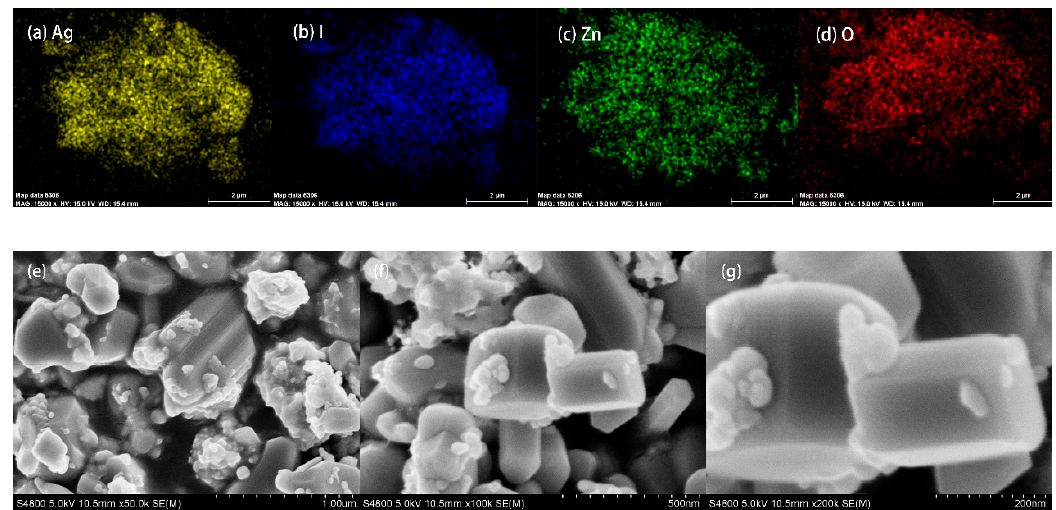
/ ZnO (X = 0.4); ( e – g ) SEM images of AgI / ZnO (X = Figure 10. ( a – d ) EDS mapping of AgI/ZnO (X = 0.4); ( e – g ) SEM images of AgI/ZnO (X = 0.4). Figure 10. ( a – d ) EDS mapping of AgI